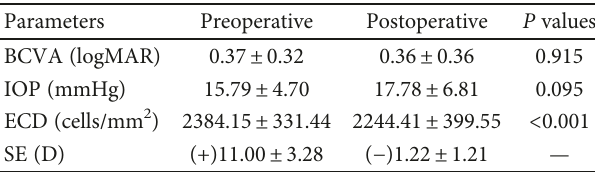
Table 1: Clinical